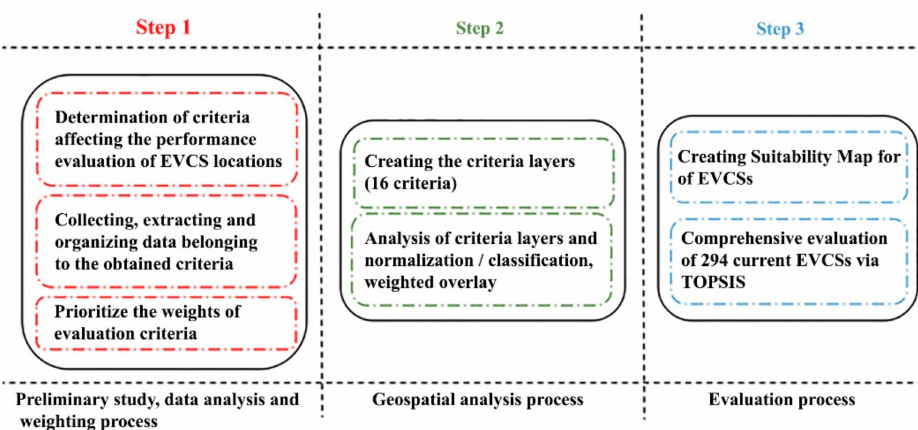
Figure 1. Steps of analysis and the related short